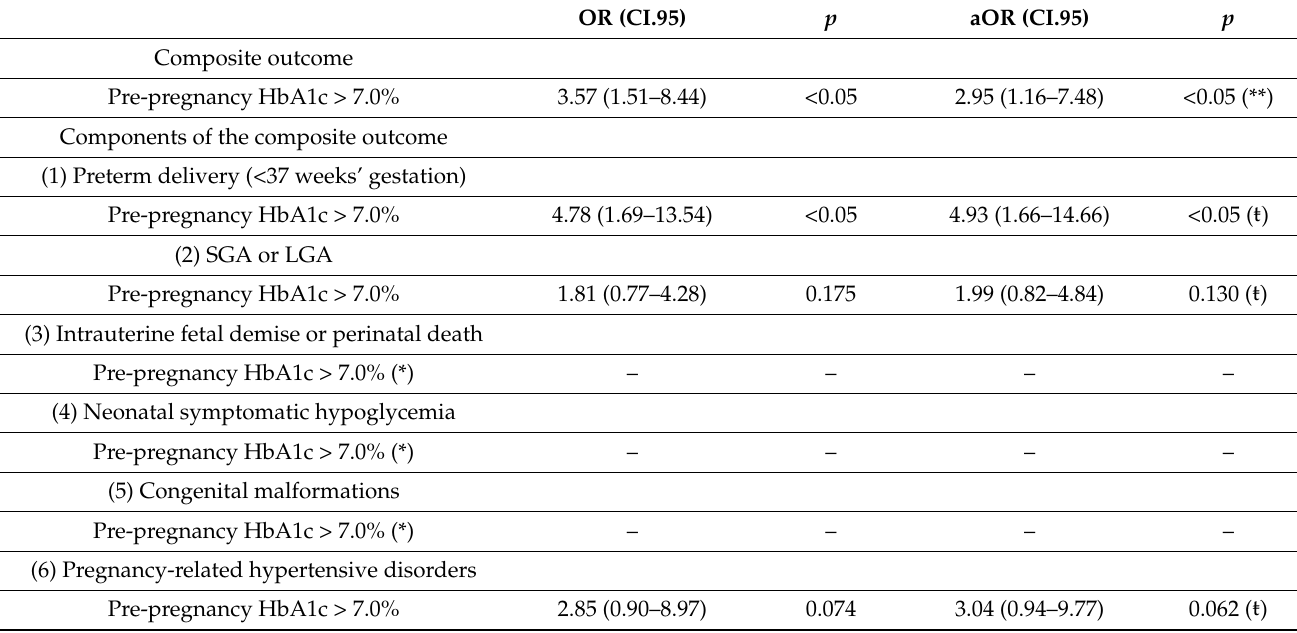
Table 4. Univariate and multivariate ((**) or (ŧ)) logistic regression analysis considering, as dependent variables, the composite outcome and the separated components of the composite outcome.